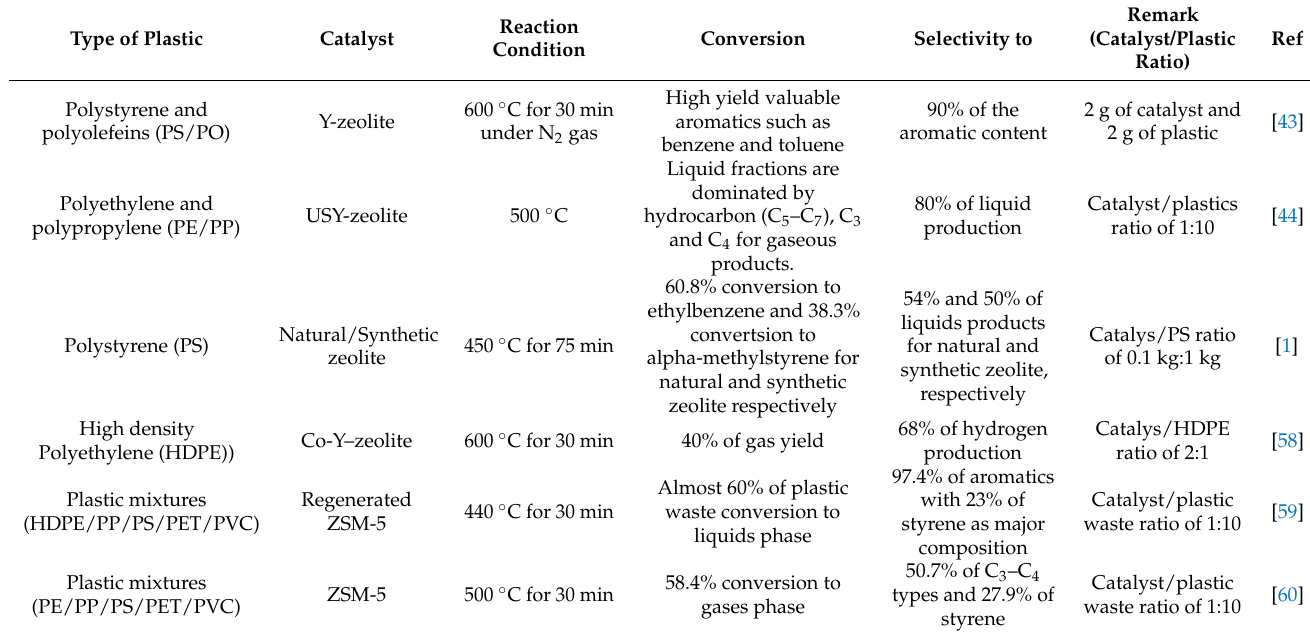
Table 2. Pyrolysis of plastic waste over zeolite-based